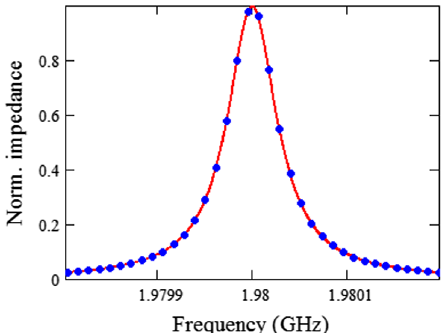
FIG. 2. A typical crab HOM (red line represents the real part of its normalized impedance) covers multiple coupled-bunch fre- quency lines (blue dots) and can therefore drive multiple coupled- bunch